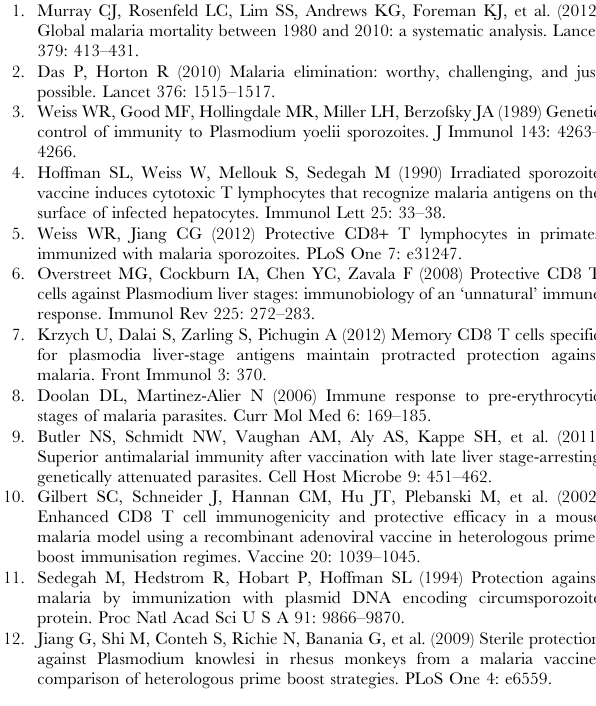
Table S1 Predicted class 1-restricted epitopes within CSP and AMA1 peptide pools predominantly recognized by protected and non-protected